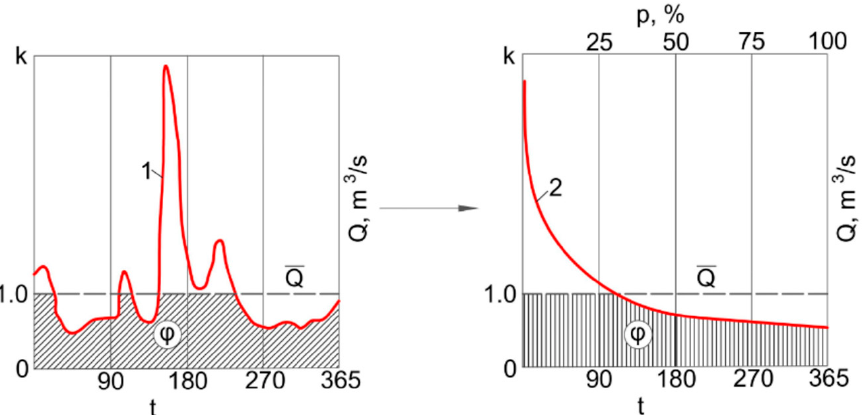
Figure 4. Hypothetical hydrograph (1) and flow duration curve (FDC) (2). Q —flow, m 3 /s; k —nor- malized flow; t —time, days; p —percentage time, %; 𝑄(cid:3364) —mean flow, m 3 /s; Φ — parameter.